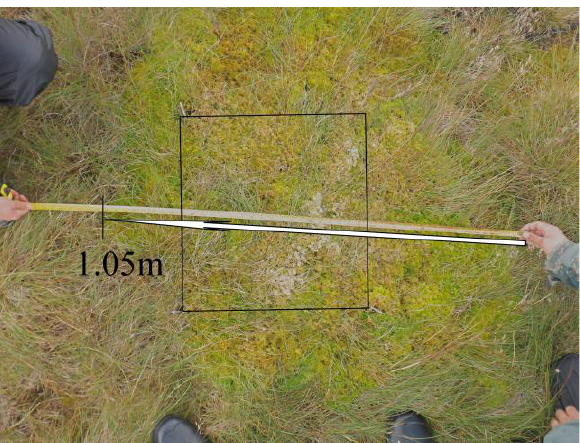
Figure 10. Example of excellent growth of S. fallax on upland blanket bog. Single Sphagnum beads were planted in each of the 100 grid squares of the 0.5 m × 0.5 m quadrat frame, into a wet peat pan with an open sward of E. angustifolium , in 2008. This photograph was taken six years